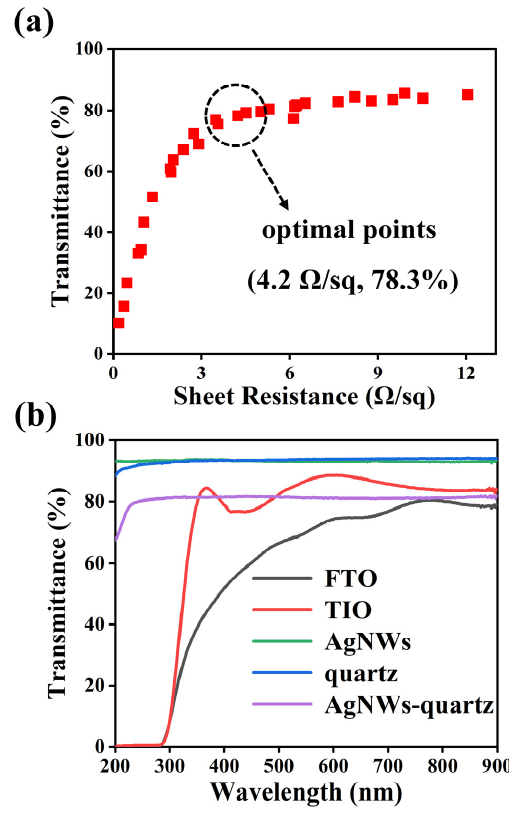
Figure 3. ( a ) Relation diagram of sheet resistance and transmittance of AgTCFs. ( b ) Transmittance curves of different TCFs.